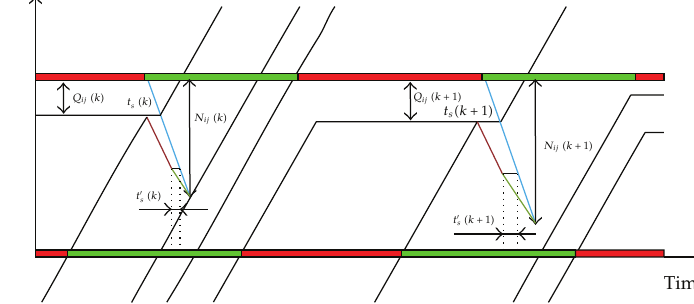
Figure 4: Arterial tra ffi c flow temporal-spatial graph in multisaturated